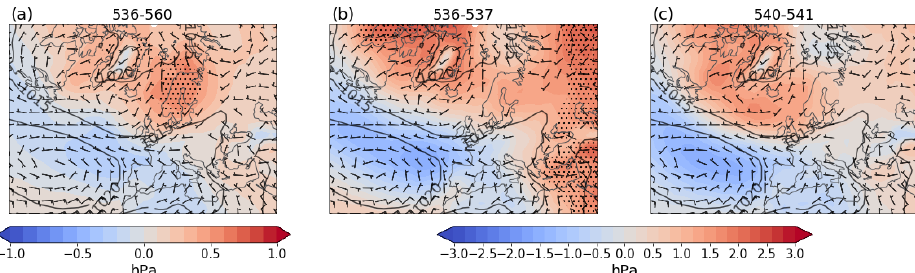
Figure 4. Maps of the North Atlantic ensemble mean sea level pressure anomalies and absolute wind for the mean growing season (AMJJAS) for (a) 536–560CE, (b) 536–537CE, and (c) 540–541CE. Anomalies are calculated with respect to 1–1850CE climatology, which is given in contours (5hPa interval). The 2 σ significant areas are stippled. Wind barbs are shown for 1, 5, and 10ms − 1 intervals.